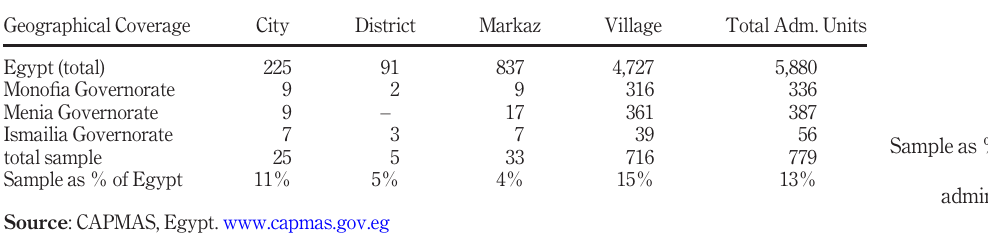
Table I. Sample as % of